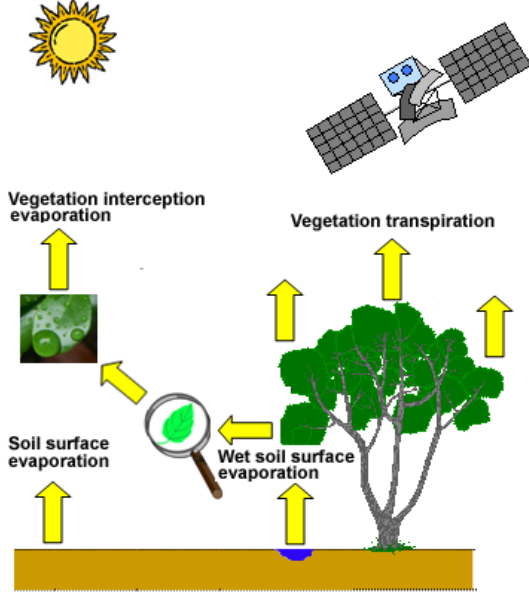
Figure 1. Schematic diagram of the modified satellite-based Priestley-Taylor model (―Tree‖ picture source derived from Anderson et al.